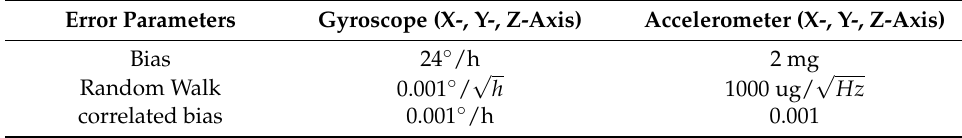
Table 4. Parameters of the sensors in a simulation experiment.